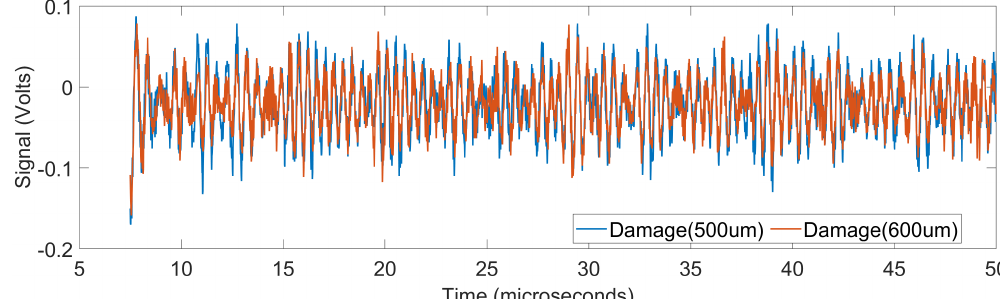
Figure 4. Time-domain signals corresponding to two damaged samples, one with damage of diameter 500 µ m and the other with damage of diameter 600 µ m. Here, the root mean square of the difference between the two signals is